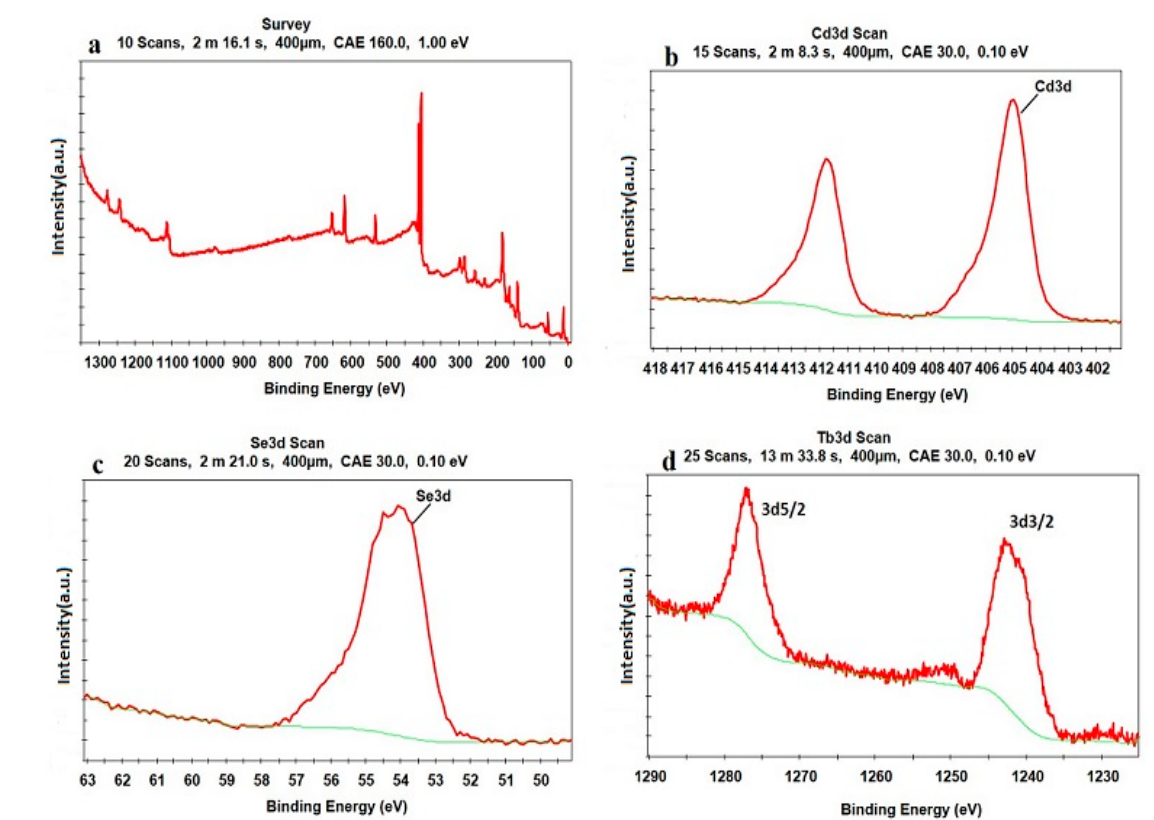
Figure 5. The XPS pattern of eight percent Tb-doped CdSe nanoparticles. ( a ) Survey pattern, ( b ) Cd 3d scan, ( c ) Se 3d scan and ( d ) Tb 3d scan.